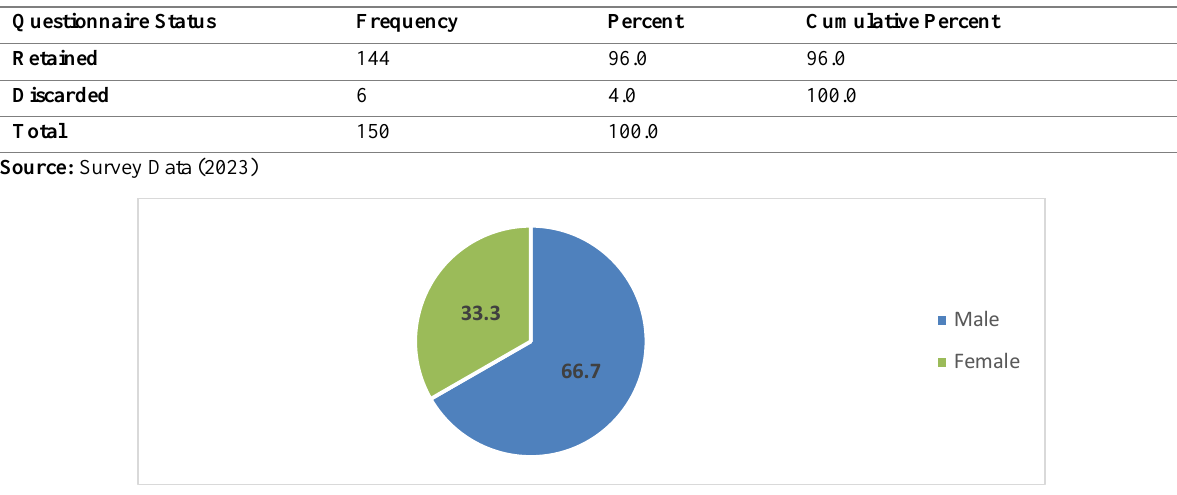
Figure 3: Gender of The Respondents; Source: Survey Data (2023)